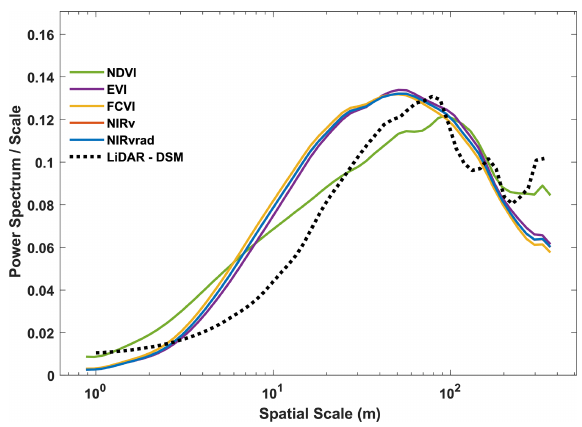
Figure 4. Ensemble wavelet power spectra for all the quantities used in this study and a lidar-derived digital surface model (DSM). Note that FCVI and NIRv are similar; thus, the NIRv curve is ob- scured by the FCVI. Ensembles were created by averaging the spec- trum of individual transects and then averaging across flights. Note that in this representation, the spectrum divided by the correspond- ing scale as a function of the log of the scale, the area beneath the curve is proportional to the